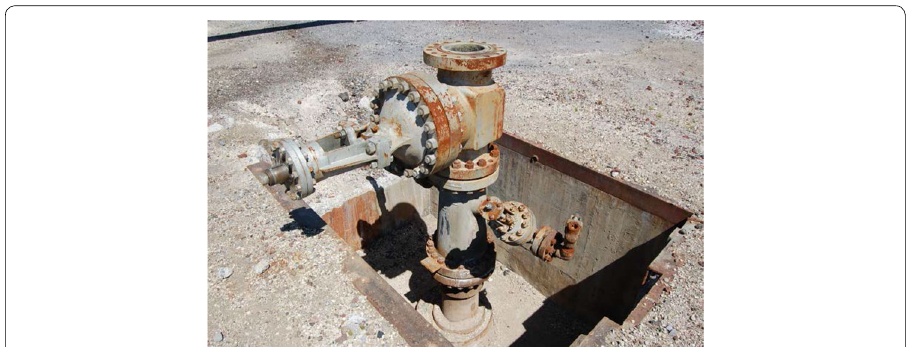
Fig. 5 The wellhead of the abandoned H-43 well in the Los Humeros geothermal field (photo: Michal